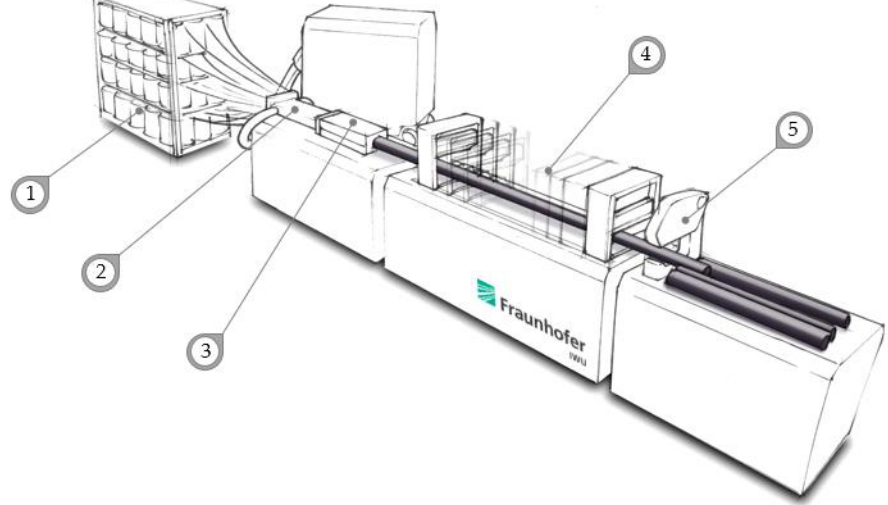
Figure 1. Pultrusion line: (1) bobbin creel; (2) impregnation unit; (3) heated die; (4) pulling devices; (5) saw.